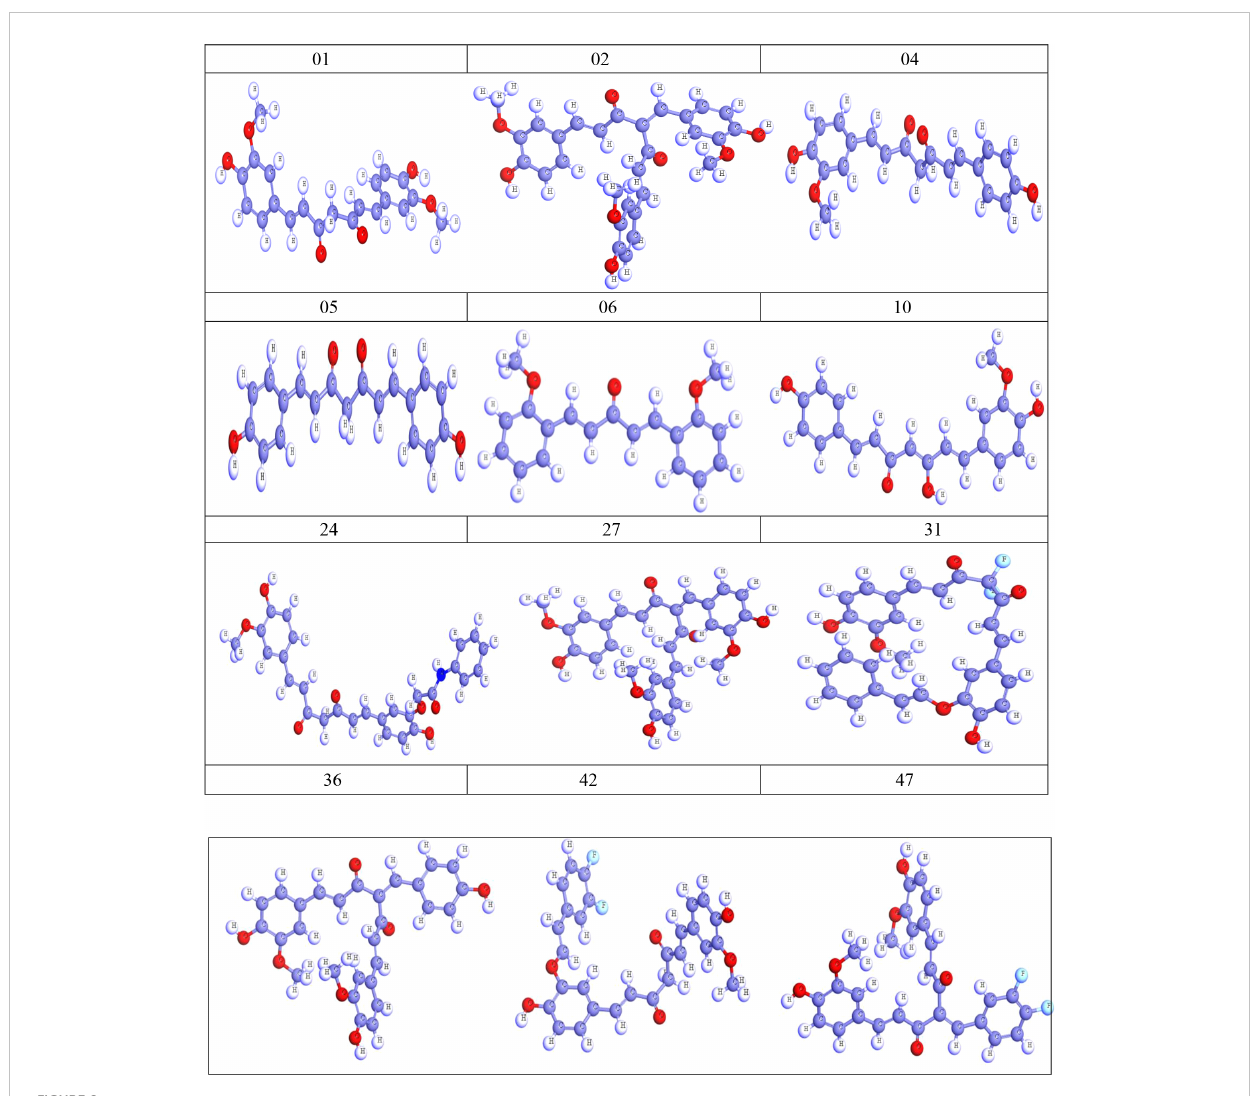
FIGURE 2 Optimized structure of curcumin